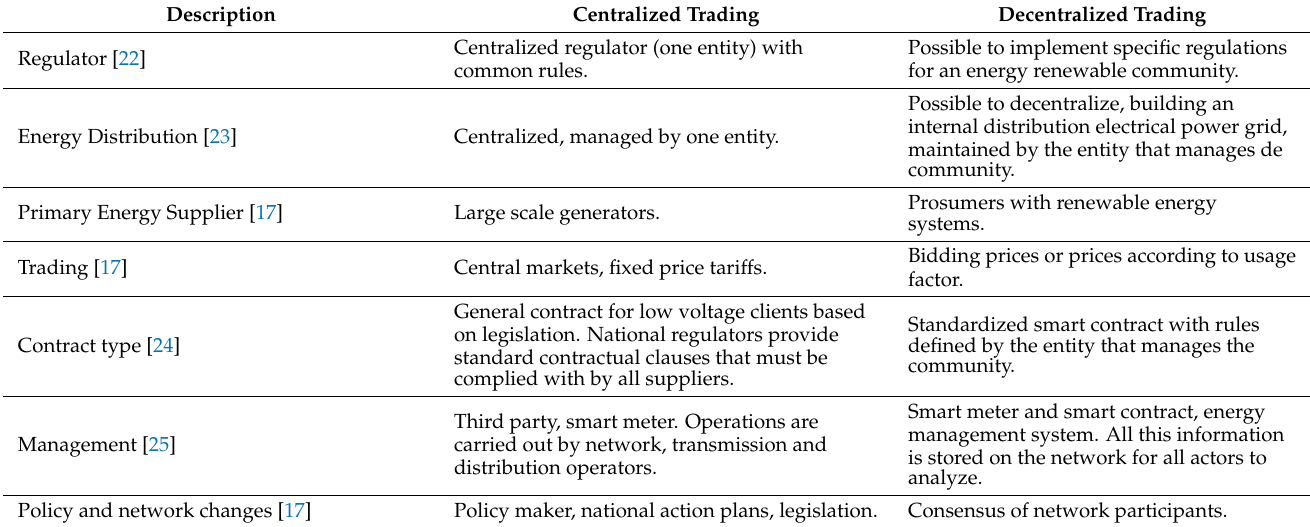
Table 1. Differences between centralized and decentralized